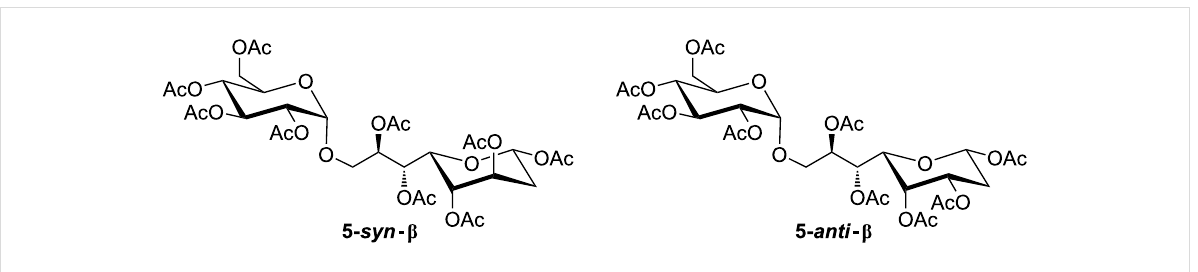
Figure 2: Structures of the main products 5- syn - β and 5- anti - β